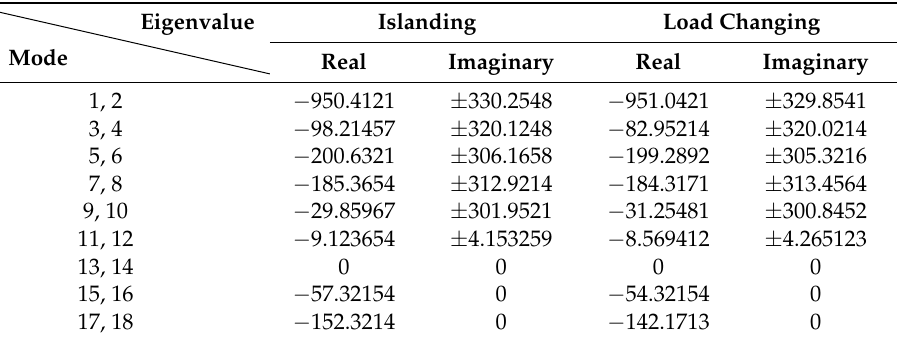
Table 5. Result of eigenvalue